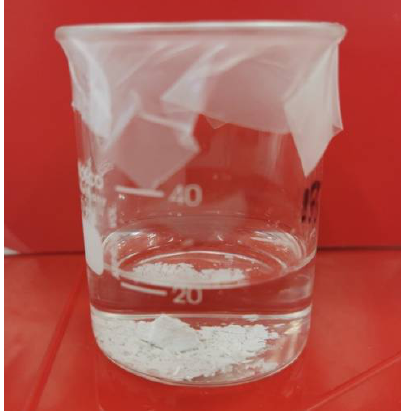
Figure 4. An amount of 1.5 g of set experimental pulp-capping material Sample 4 in 20 mL of Hank’s Balanced salt solution.